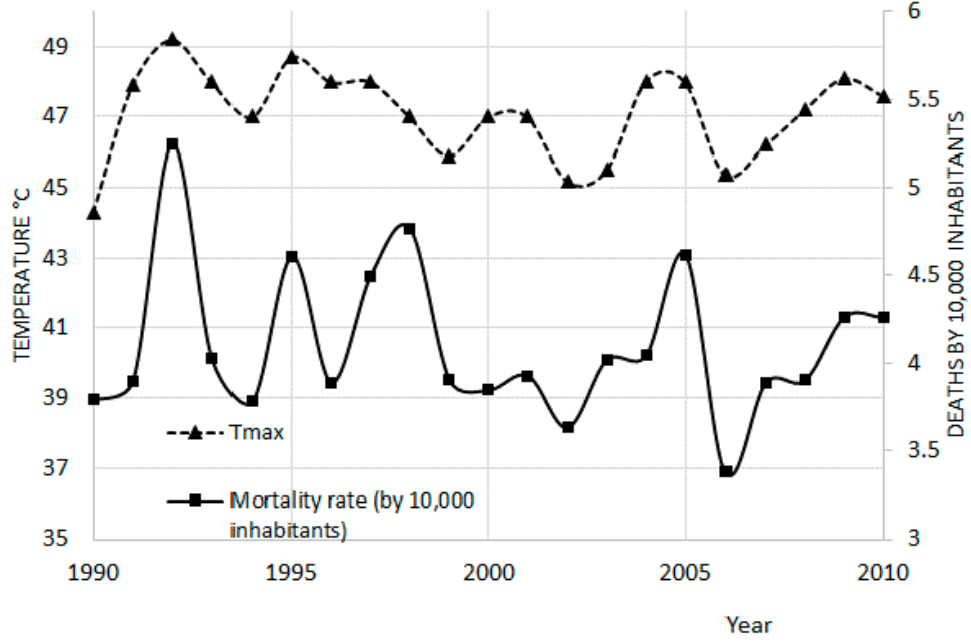
Figure 7. Mortality rate per 10,000 inhabitants and maximum monthly temperature in Mexicali during August (1990 to 2010).